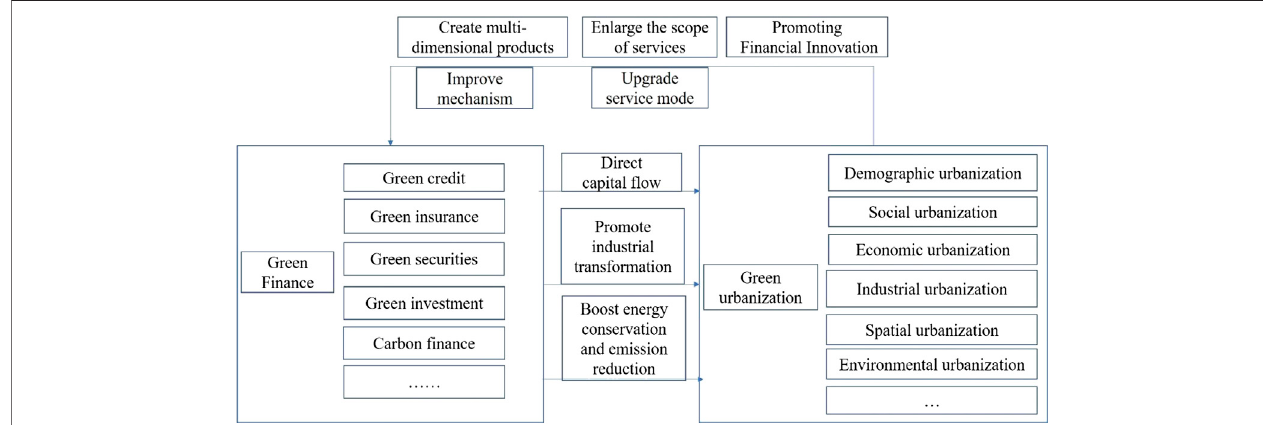
FIGURE 2 | Theoretical framework.